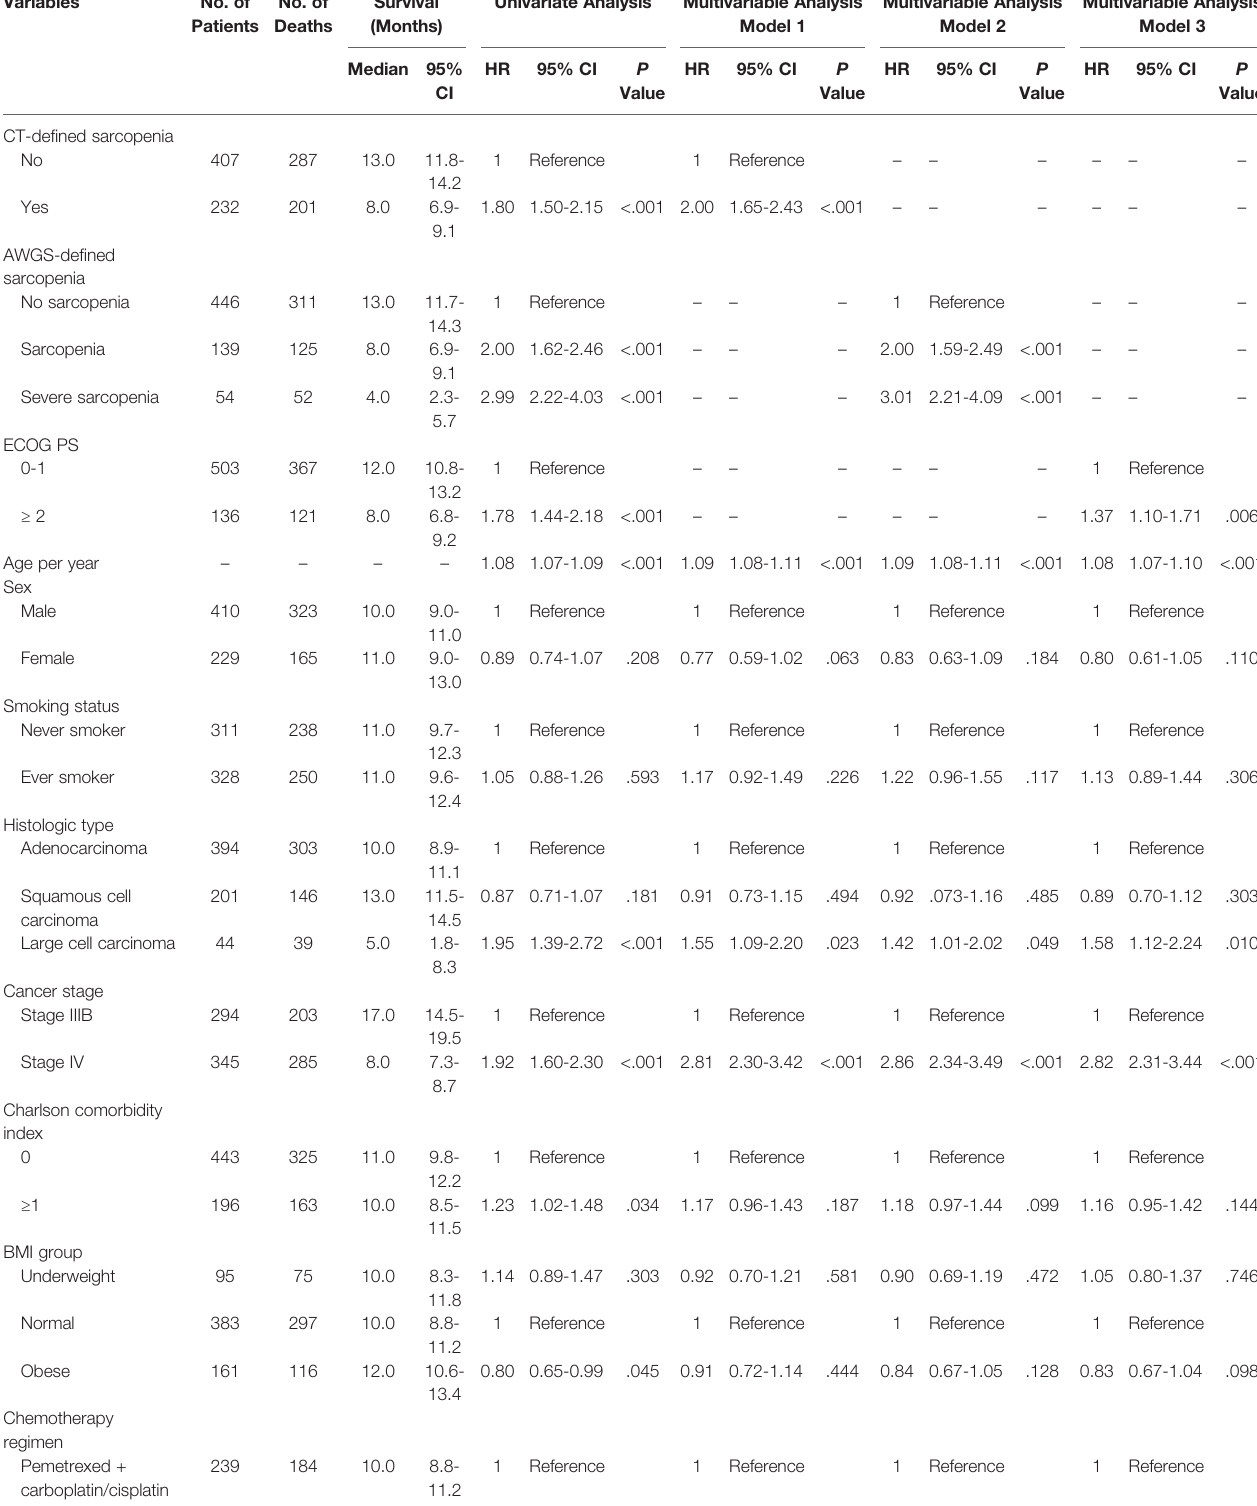
TABLE 2 | Median survival and univariate and multivariable analyses for predictors of overall